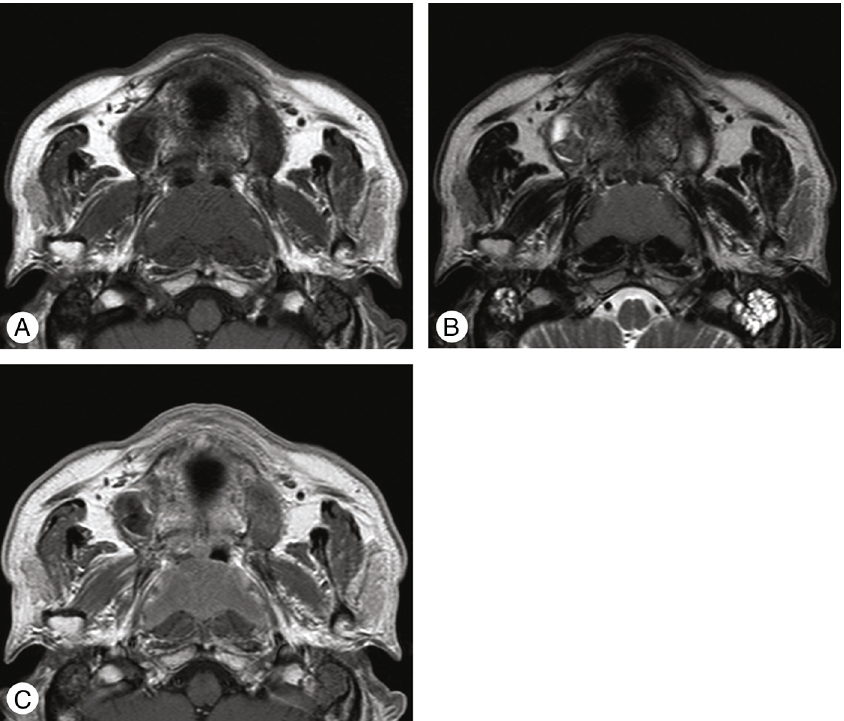
Figure 2 Magnetic resonance (MR) images of nasopharyngeal mass. Bilateral nasopharyngeal mass reveals low signal intensity on T1-weighted image (T1WI) (A) and intermediate signal intensity on T2WI (B). Postcontrast image (C) demonstrates moderate